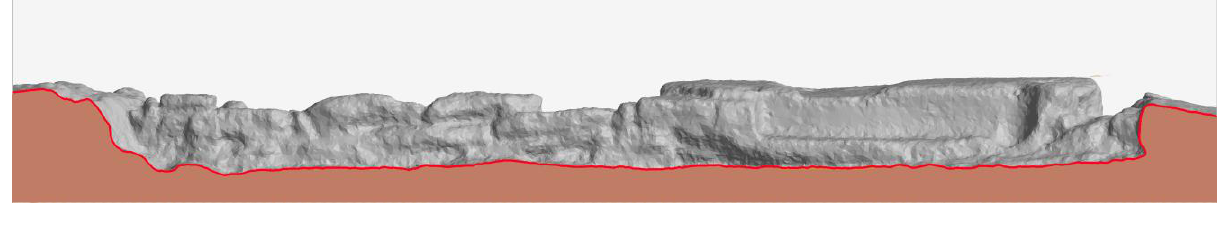
Figure 7. Cross-section of the workshop: shaded mesh